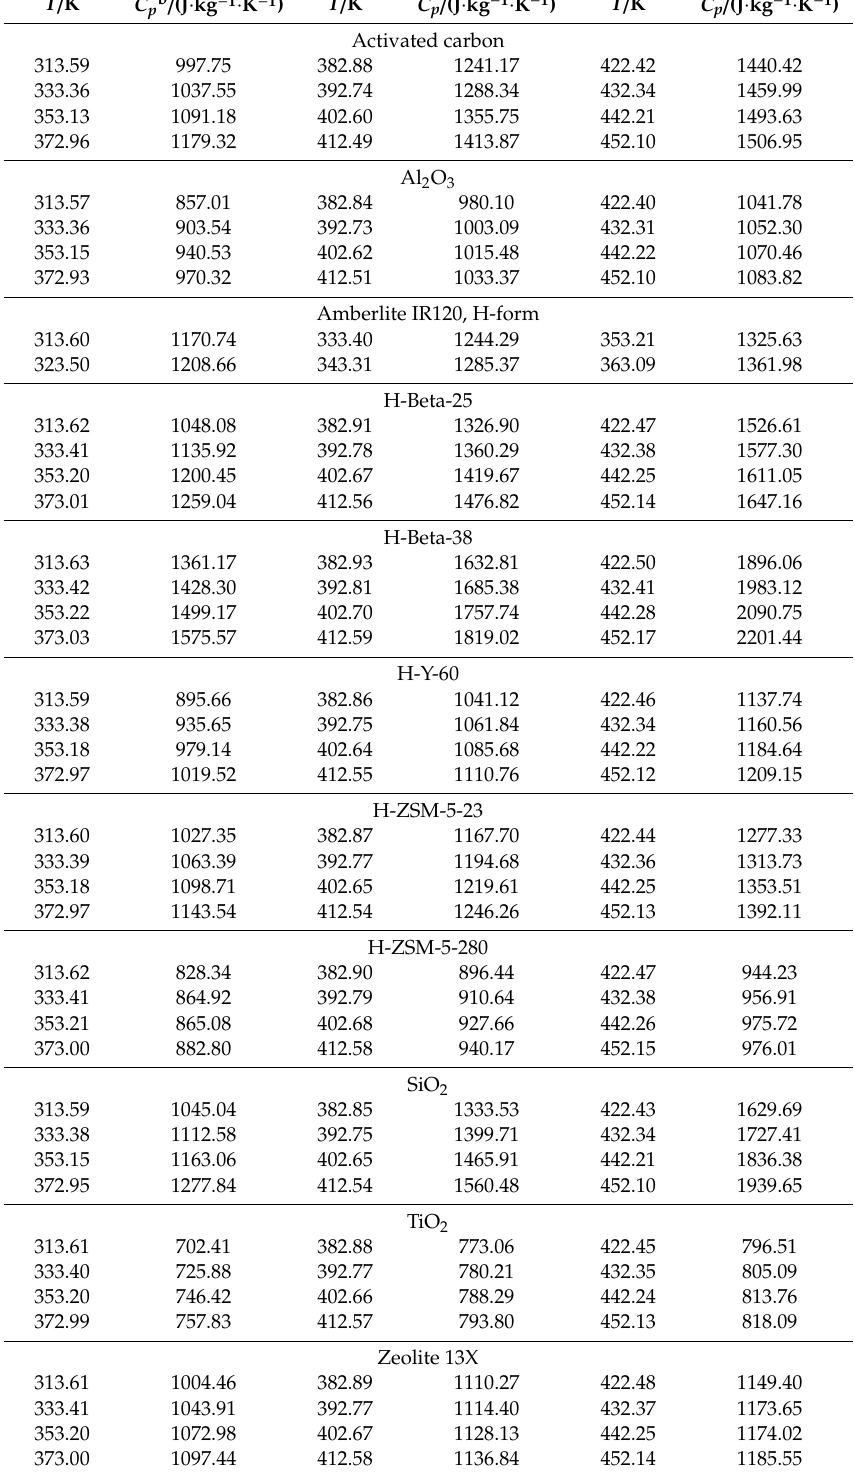
Table 3. Average Values of Specific Heat Capacity ( C p ) of Catalytic Materials as a Function of Temperature ( T ) a